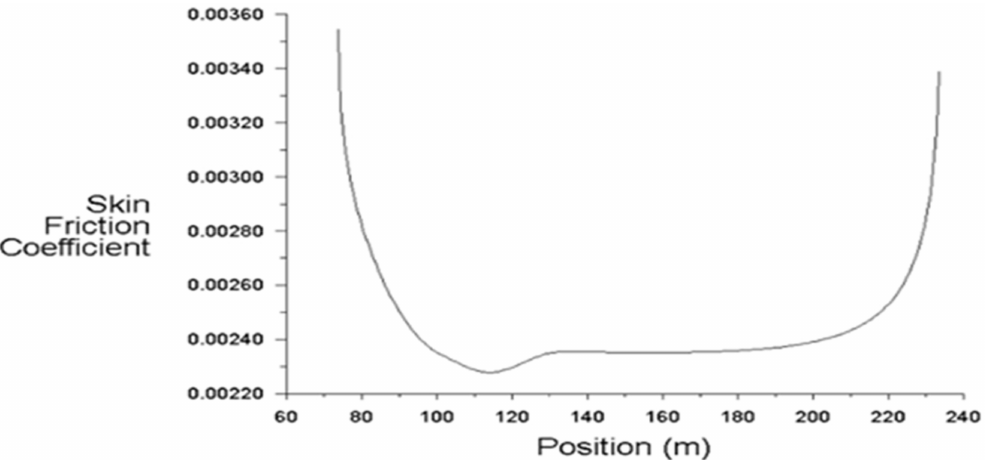
Figure 4. Skin friction coe ffi cient on the non-air lubricated